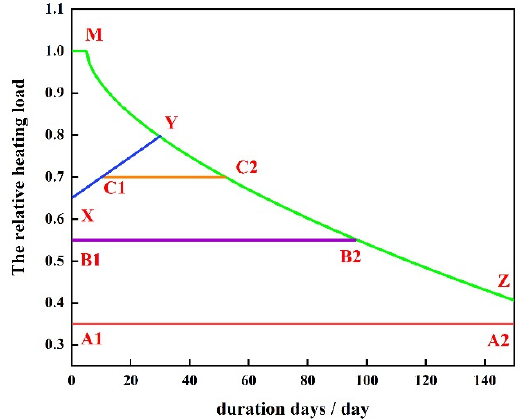
Figure 5. The operation mode of the heat pump in the waste heat recovery system.